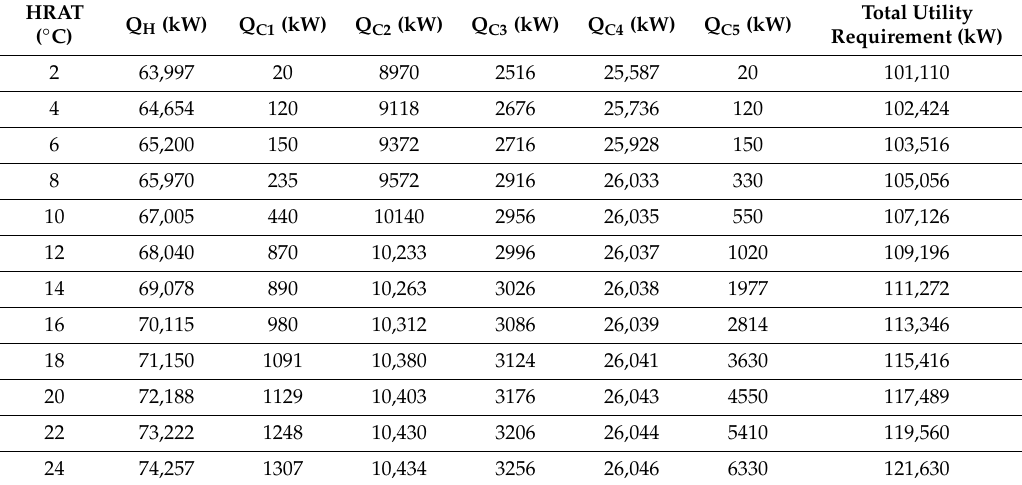
Table A9. Hot and cold utilities heat duties for HEN at di ff erent HRAT values using option